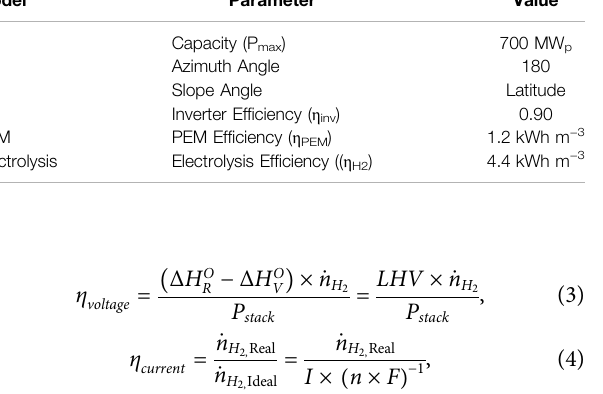
TABLE 1 | Summary of PV – Electrolysis – PEM system components. Model